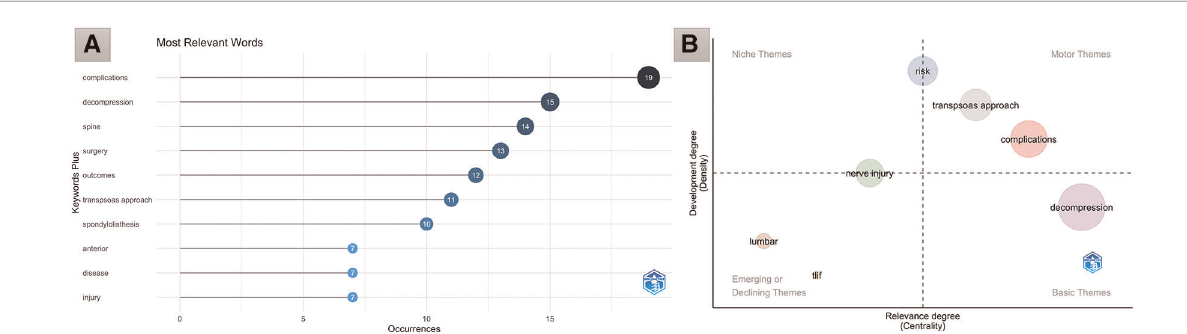
FIGURE 2 ( A ) The top 10 most cited keywords in the fi eld of pre-psoas oblique lumbar interbody fusion. ( B ) Thematic map. Bottom right is the basic themes, top right is the motor themes, top left is the niche themes, bottom left is the emerging or declining